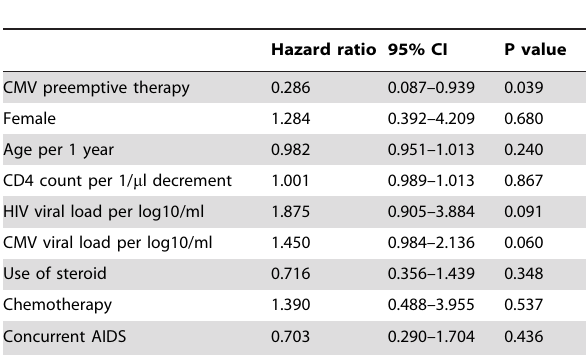
Table 2. Results of univariate analysis to estimate the risk of various factors in inducing CMV end-organ